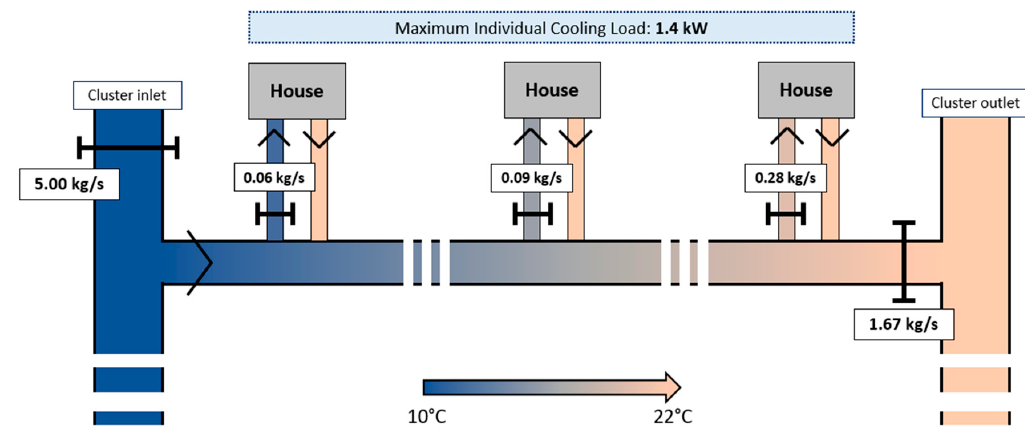
Figure 14. Cooling arrangement in the clusters.